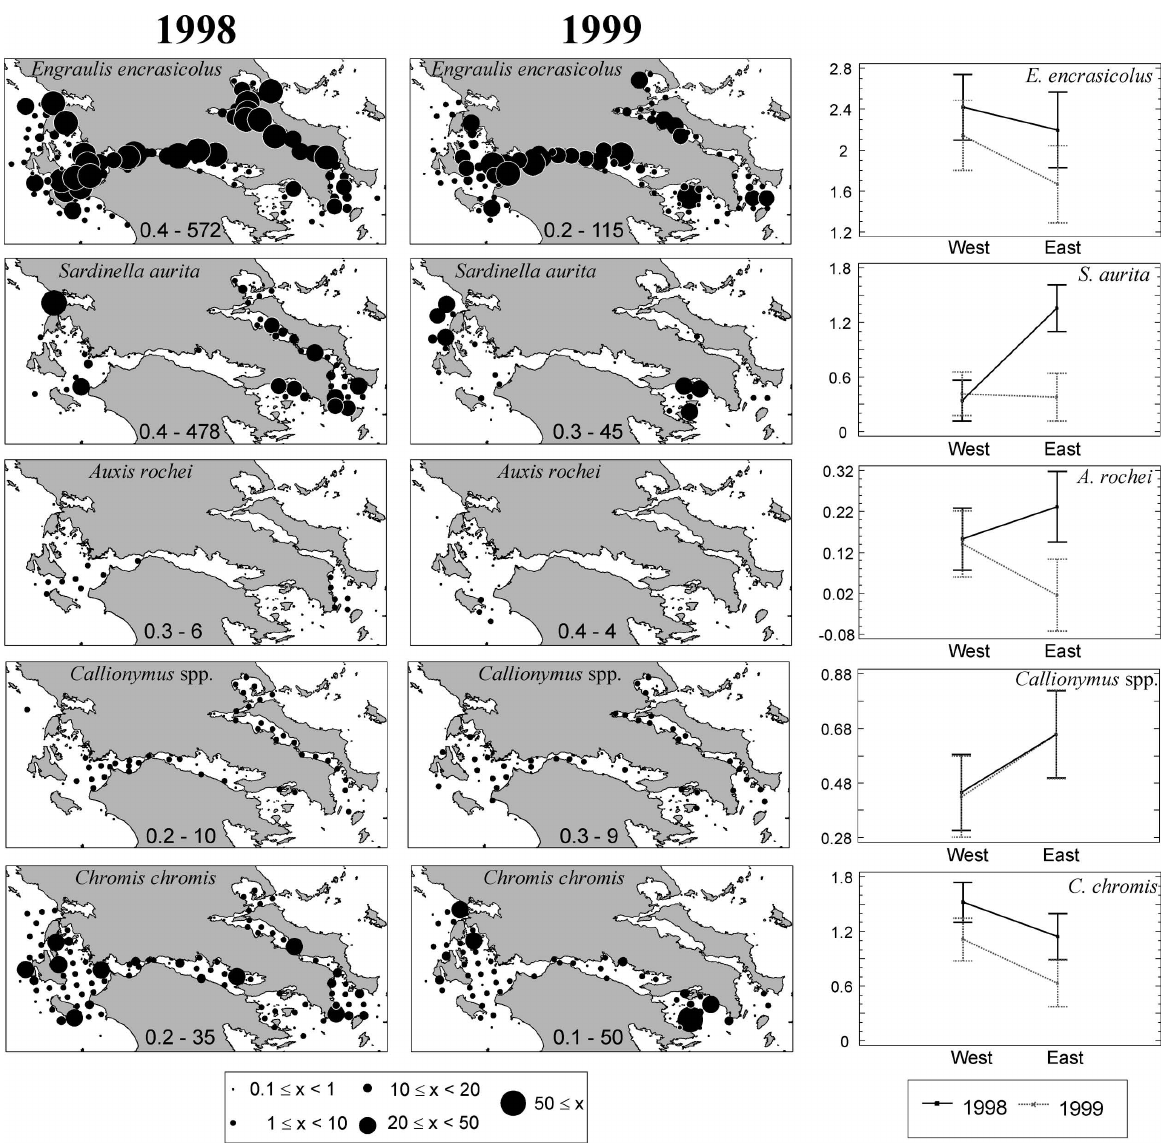
Fig . 5. – Distribution and abundance of larvae (ind m -2 ) of selected taxa during the two surveys. The range for abundance values (positive stations) is given in each map. Interaction plots (region × survey) for log(x+1)-transformed abundance (ind m -2 ) are also given (right panel) with 95% Bonferroni-corrected confidence